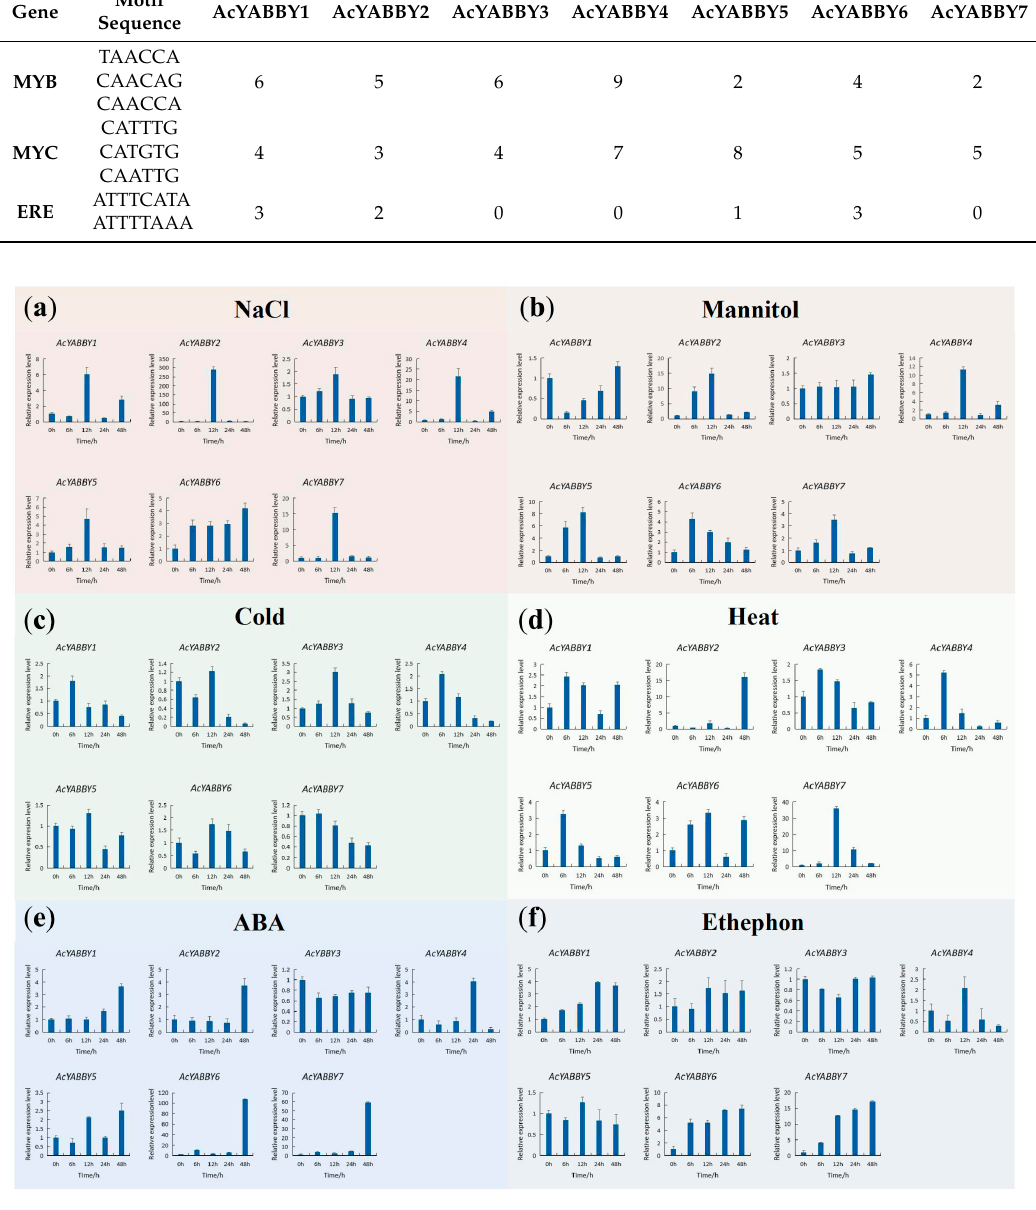
Figure 7. Expression profiles of 7 selected AcYABBY genes in response to various abiotic stress treatments. ( a ) NaCl treatment. ( b ) Mannitol treatment. ( c ) Cold treatment. ( d ) Heat treatment. ( e ) ABA treatment. ( f ) Ethephon treatment. RT-qPCR data were normalized using pineapple PP2A gene as reference gene. Error bars indicate Standard Deviation.